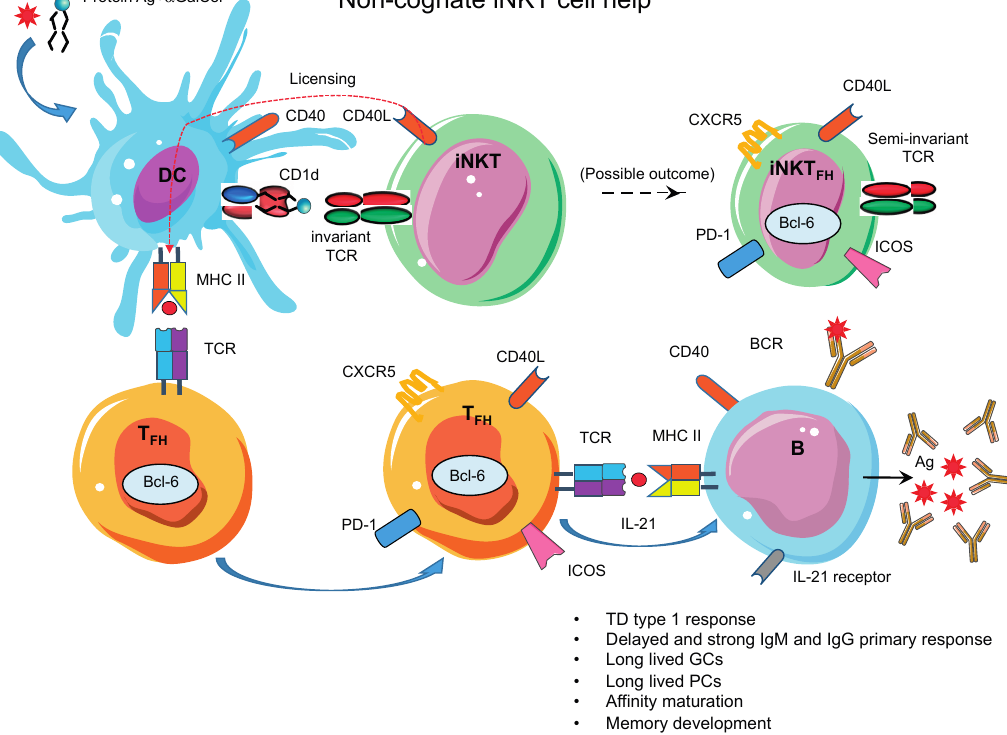
Figure 2. Non-cognate iNKT cell help for B-cell responses. iNKT cells provide indirect, non-cognate help to B cells in case of immune responses elicited by protein Ags admixed with α GalCer. In this case, proteins generate peptides that can be recognized by MHC II-restricted CD4 + T FH cells. Protein Ags and α GalCer mixtures get in contact with CD8 α + DCs, which internalize both and present the lipid and the protein-derived peptides into